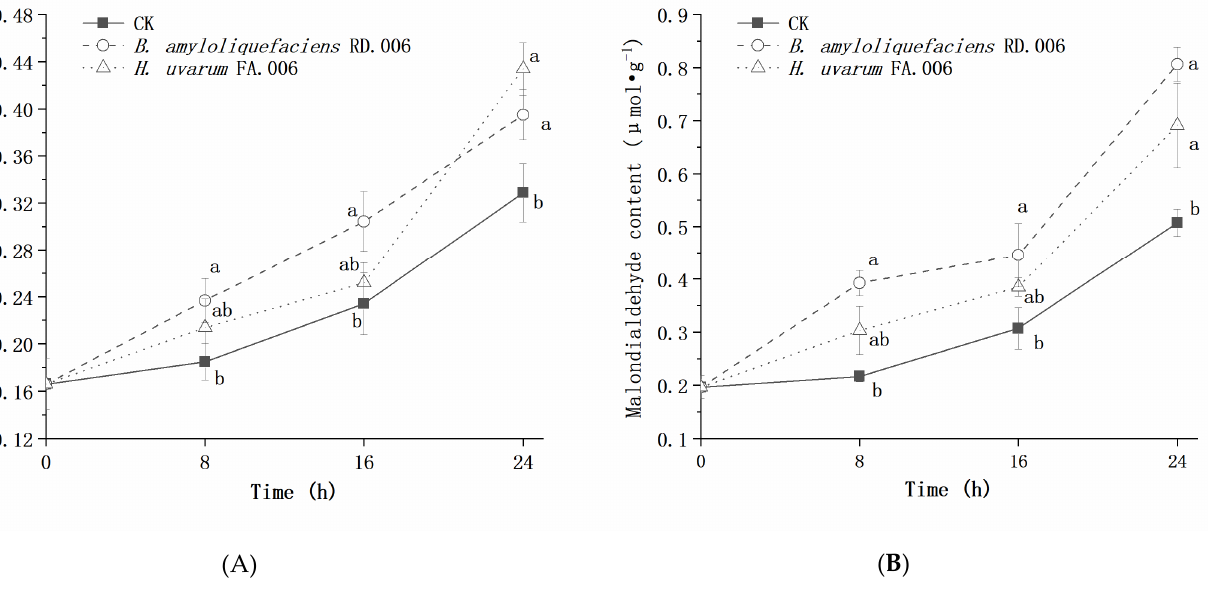
Figure 6. Effect of a biocontrol agent on nucleic acid leakage ( A ) and malondialdehyde content ( B ) of Bot. dothidea JNHT01. Error bars represent standard deviations from the mean. a–b: different letters at the same time indicate significant differences with a p < 0.05.